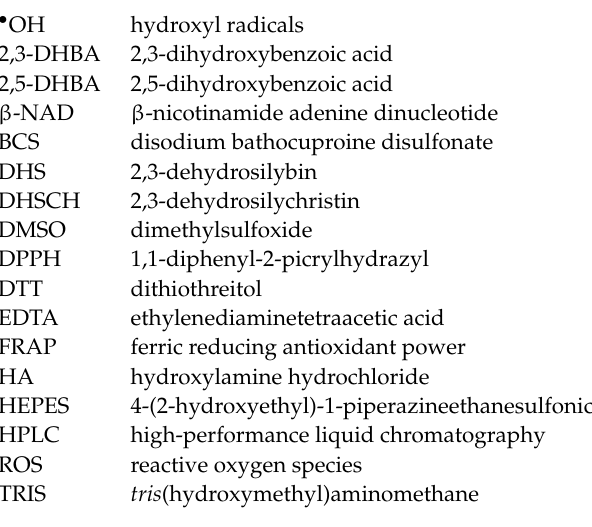
iron. Figure S3. Comparison of cupric-chelation activity between 2,3-dehydrosilychristin and 2,3- dehydrosilybin (hematoxylin method) with 95% confidence intervals. Figure S4. Comparison of copper-chelation activity between 2,3-dehydrosilychristin and 2,3-dehydrosilybin (the BCS method) with 95% confidence intervals. Figure S5. Comparison of iron chelating activity between 2,3- dehydrosilychristin and 2,3-dehydrosilybin with 95% confidence intervals. Figure S6. Comparison of cupric reduction between 2,3-dehydrosilychristin and 2,3-dehydrosilybin using 95% confidence intervals of linear regression